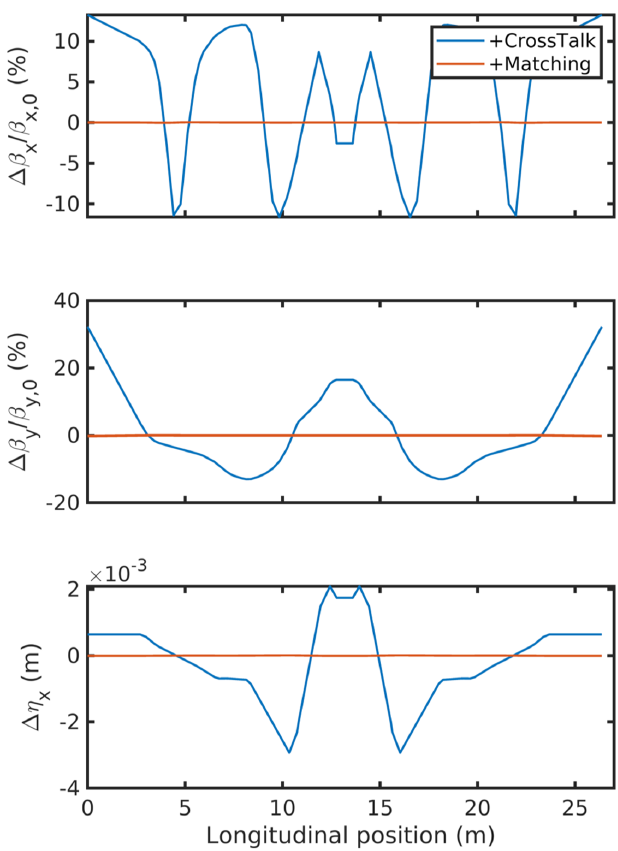
FIG. 12. Optics distortions introduced by magnetic cross talks before and after correction (matching) for one HMBA cell. The top figure is the horizontal β function, the middle one the vertical, and the bottom one the dispersion. The comparison is done with respect to the design lattice.